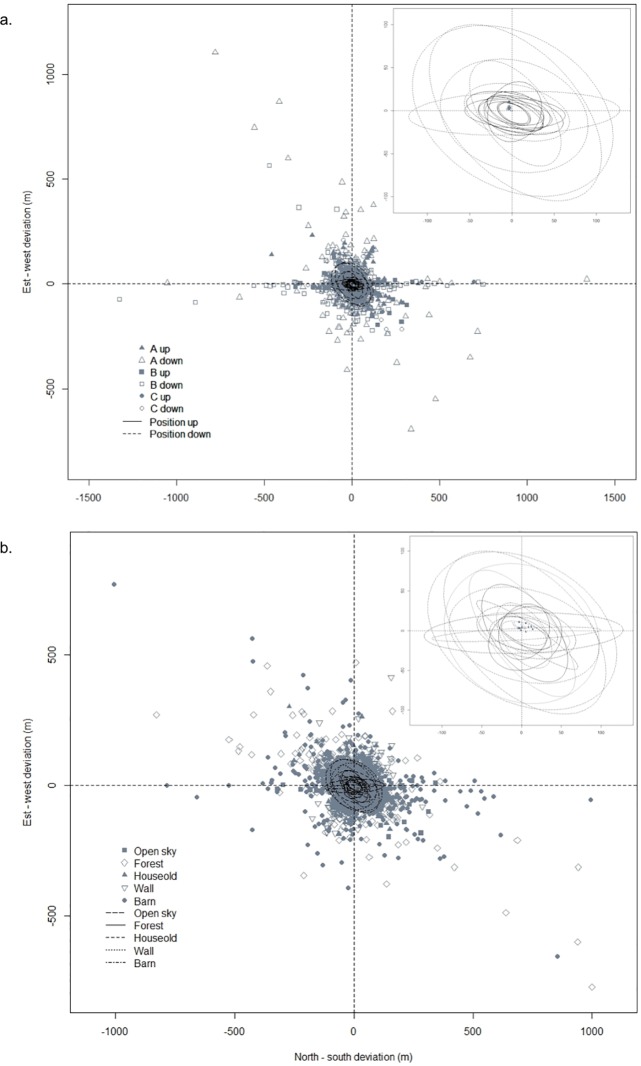
Systematic error.Location errors from 39 GPS CatLog data loggers relative to the National Geodetic Survey coordinates obtained of (a) 700–2300 fixes per unit under antenna positions (up or down) and fix intervals (program A, program B or program C) in an open habitat and (b) 250–2300 fixes per unit under different habitats with fixed conditions. Ellipses represent 95% confidence areas and centroids represent the average location error.